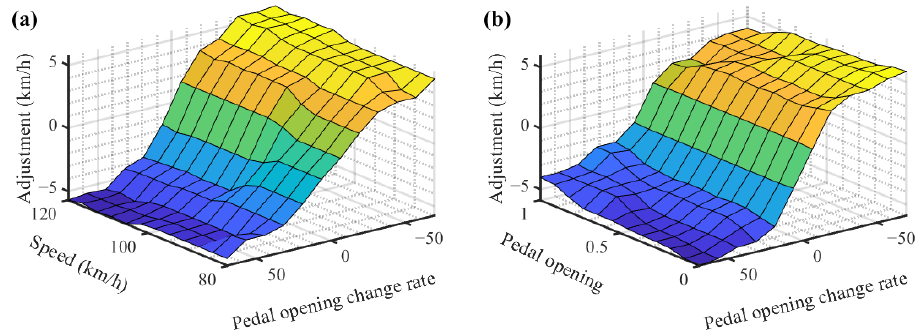
Figure 11. Characteristic maps of fuzzy logic in dynamic shifting strategy: (a) Fuzzy logic for speed, pedal change rate and adjustment; (b) Fuzzy logic for pedal opening, pedal change rate and adjustment.